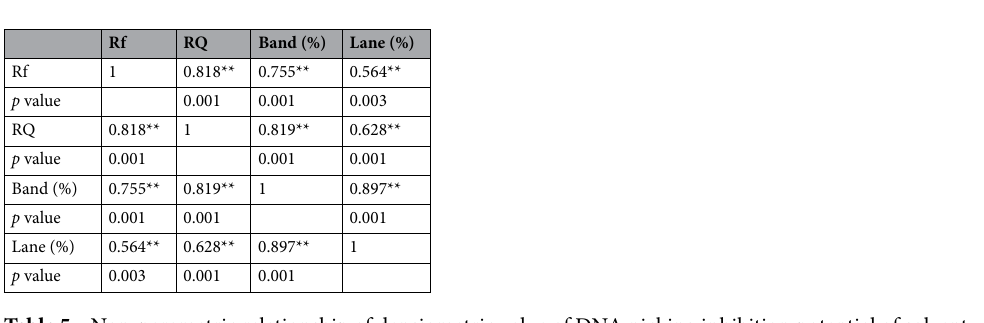
Table 5. Non-parametric relationship of densiometric value of DNA nicking inhibition potential of solvent extracts of T. arjuna.